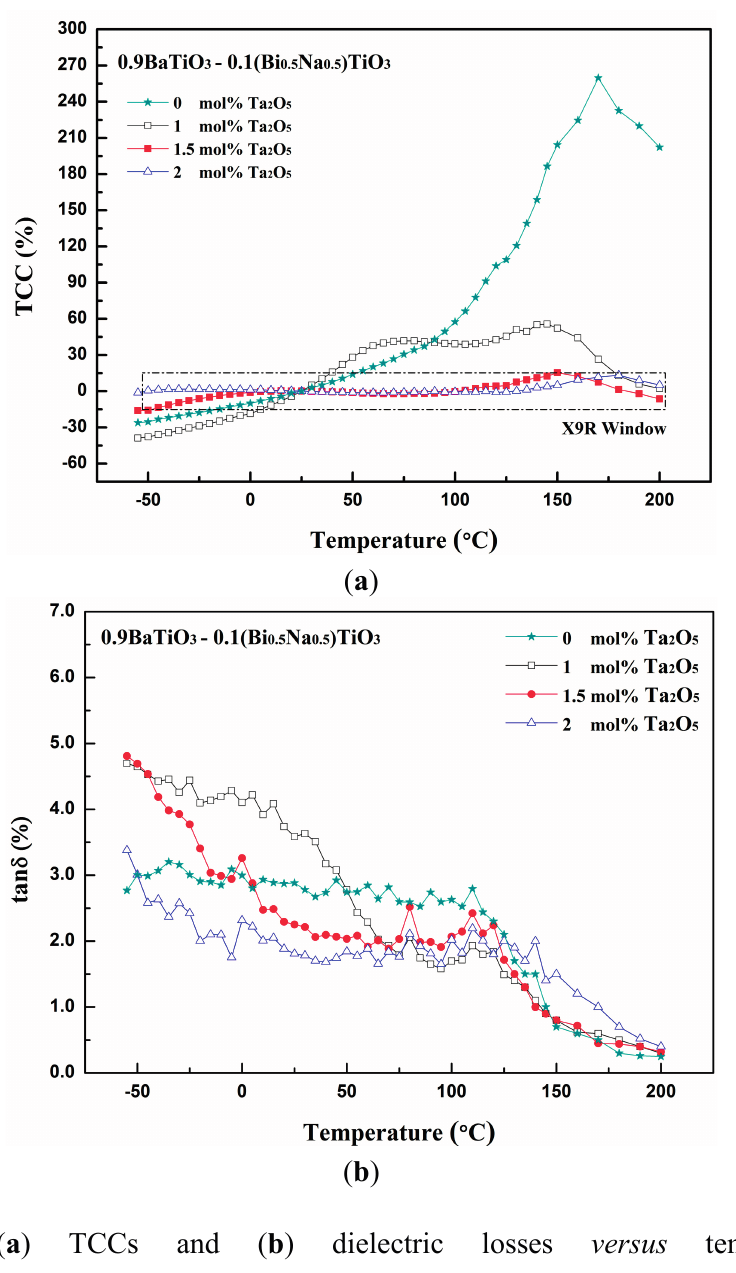
Figure 4. ( a ) TCCs and ( b ) dielectric losses versus temperature of 0.9BaTiO 3 –0.1(Bi 0.5 Na 0.5 )TiO 3 ceramics with various amounts of Ta 2 O 5 sintered at 1215 °C (measured frequency = 1 kHz; heating rate = 2 °C/min; applied voltage = 1